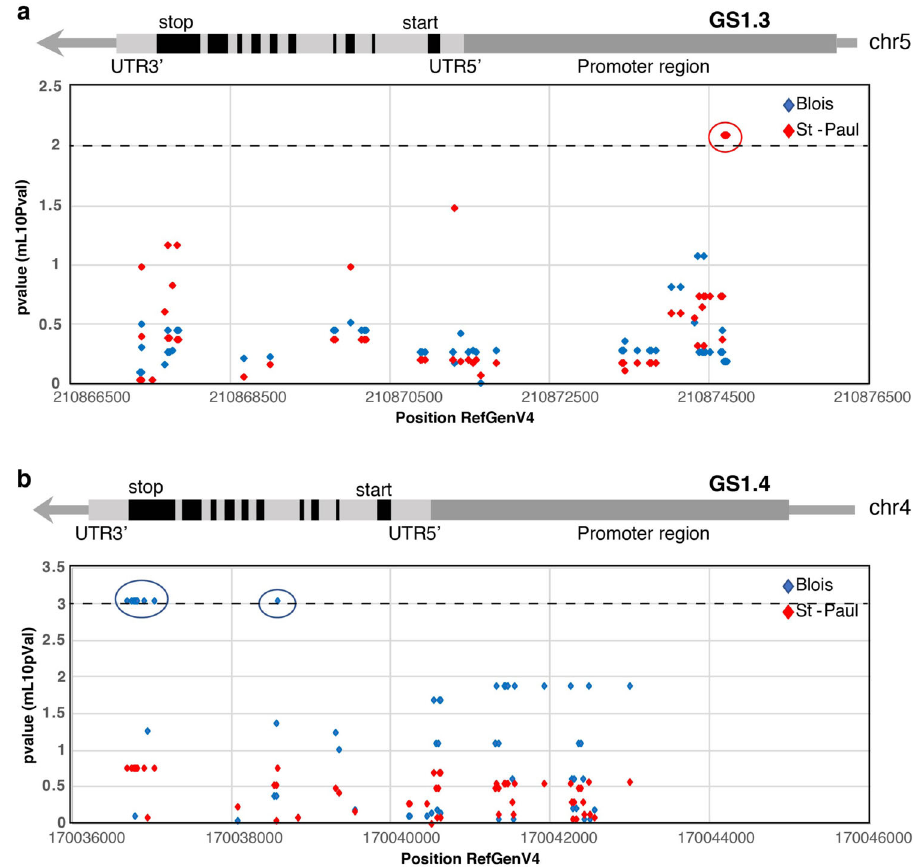
Fig. 4 Manhattan plots showing SNP association with the genes encoding Gln1-3 and Gln1-4 . Manhattan plots showing association mapping p -values associated with kernel yield at 15% moisture (KY15) and genomic location of SNPs located in gene encoding GS1.3 ( a ) and GS1.4 ( b ). Each symbol represents the p -value of a single SNP associated with a trait measured in the fi eld trial conducted in Blois in 2015 (blue) and in Saint-Paul in 2016 (red). The horizontal dashed line represents the signi fi cant threshold with a − log 10 ( p -value) >2 and >3 for Gln1-3 and Gln1-4 respectively. The six TAS markers (at markers C05M60, C05M61, C05M62, C05M63, C05M64, and C05M65) for Gln1-3 and the nine TAS markers (at markers C04M01, C04M02, C04M03, C04M05, C04M06, C04M07, C04M08, C04M10, and C04M15) for Gln1-4 are indicated by circles. In the upper part of the fi gure is indicated the position of the introns, exons, 3 ′ UTR, 5 ′ UTR, and promoter region of the two genes. association study in the different locations and over the different Table 1 SNP association with the genes encoding Gln1-3 and years are presented in Supplementary Data 5. Pairwise Linkage Gln1-4 . Disequilibrium (LD) measured among the SNP in the Gln1-3 genomic region revealed that the six identi fi ed TAS were in complete LD ( R ² = 1). These six TAS were located between